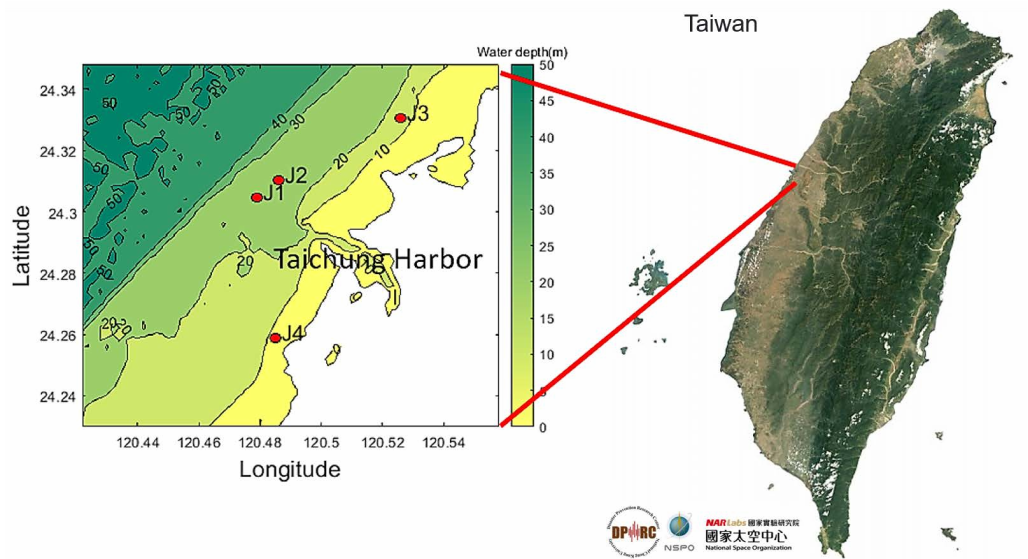
Figure 4. Hydrophone station